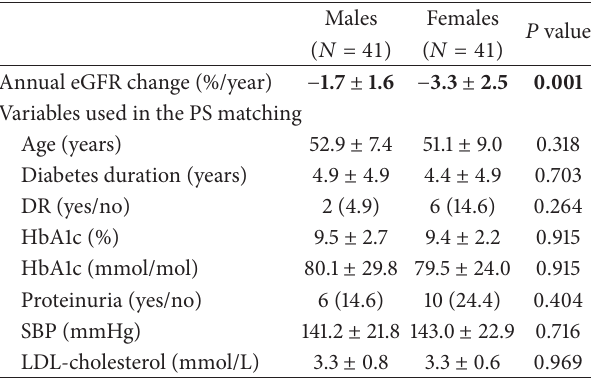
Table 5: The clinical characteristics of males and PS-matched